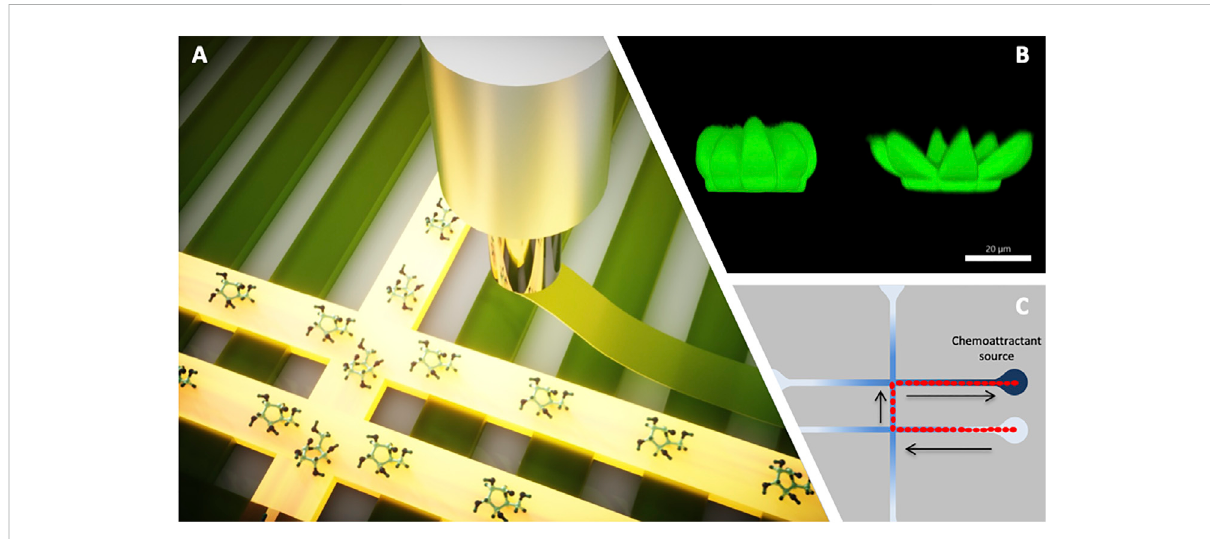
Graphicaldepictionofresponsivemicrostructuresandmicrovehiclesthatcanbeintegratedin fl uidicdevicesforfunctionality; (A) 3Dprintingby extrusion of aresponsive hydrogel scaffold that fl uoresceswheninteractingwith theanalyteof interest — suchactive componentscan be3Dprinted as part of the 3D printing of the fl uidic platform itself; a demonstration of such a scaffold is described by Bruen et al., 2020; (B) confocal image of fl ower-likemicrostructuresinthepassive(closed)andactive (open)state — suchactivecomponentscanbefabricatedinsidethe fl uidicchannel by direct laser writing and used to release active content when the chemistry of the fl uid changes above a certain threshold; image realized by Alexa Ennis and the authors, unpublished data; (C) Schematic illustration showing sequentially the positions of a droplet (depicted in red) that spontaneously moves from an initial location through microchannels via chemotaxis towards the source of the chemical attractant along a concentration gradient arising from localized damage. Upon arrival the droplets can be programmed to perform simple repair tasks (e.g., merging with droplets containing co-reactants for polymerisation); such chemotactic droplets have been demonstrated by Francis et al., 2015. All images come from the research resources of the